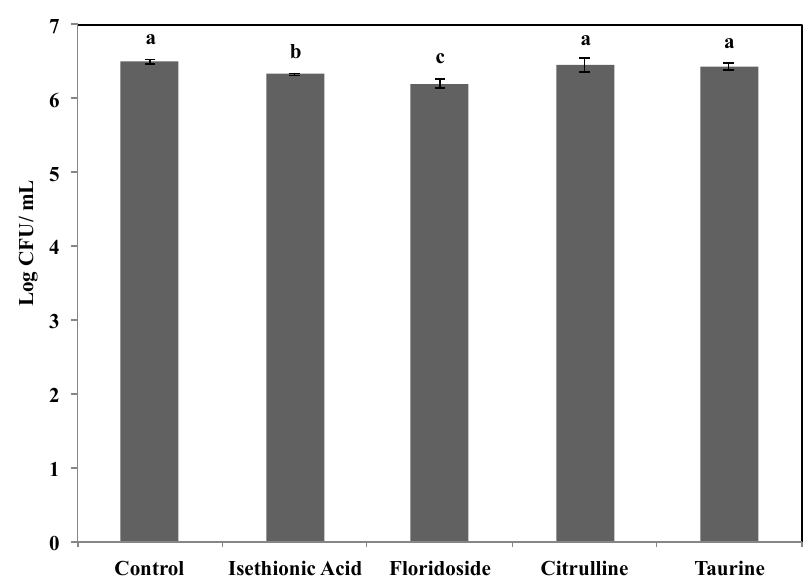
Figure 2. Antimicrobial effects of pure compounds from seaweed water extract (SWE) of CC on the growth of S. Enteritidis . Values with different superscript letters were significantly different ( p < 0.05). Values represented mean ± standard deviation from three independent experiments ( n = 9).